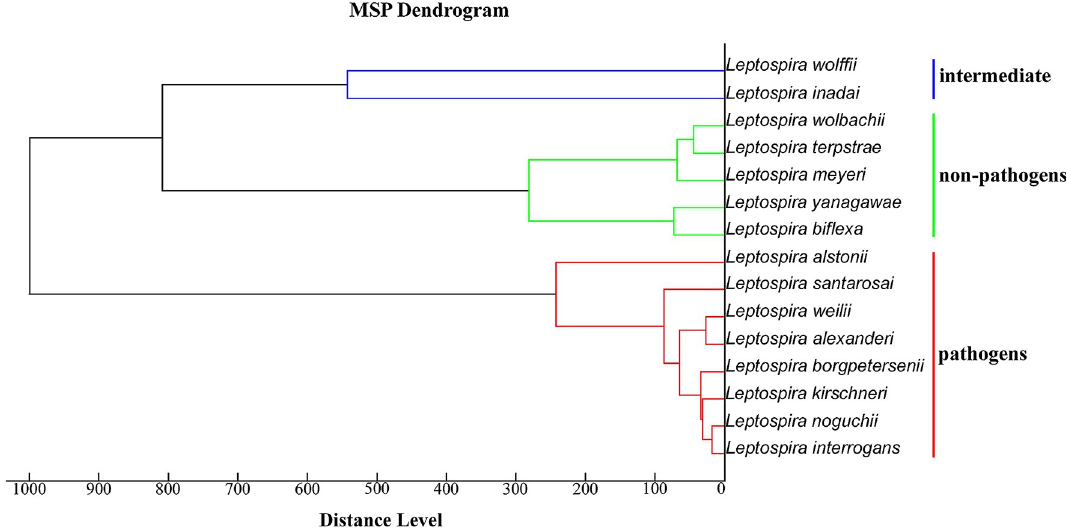
Fig 2. Dendrogram based on main spectrum profile (MSP) of 15 reference Leptospira spp. The clustering based on MSP of pathogenic, intermediate and non-pathogenic group were determined.